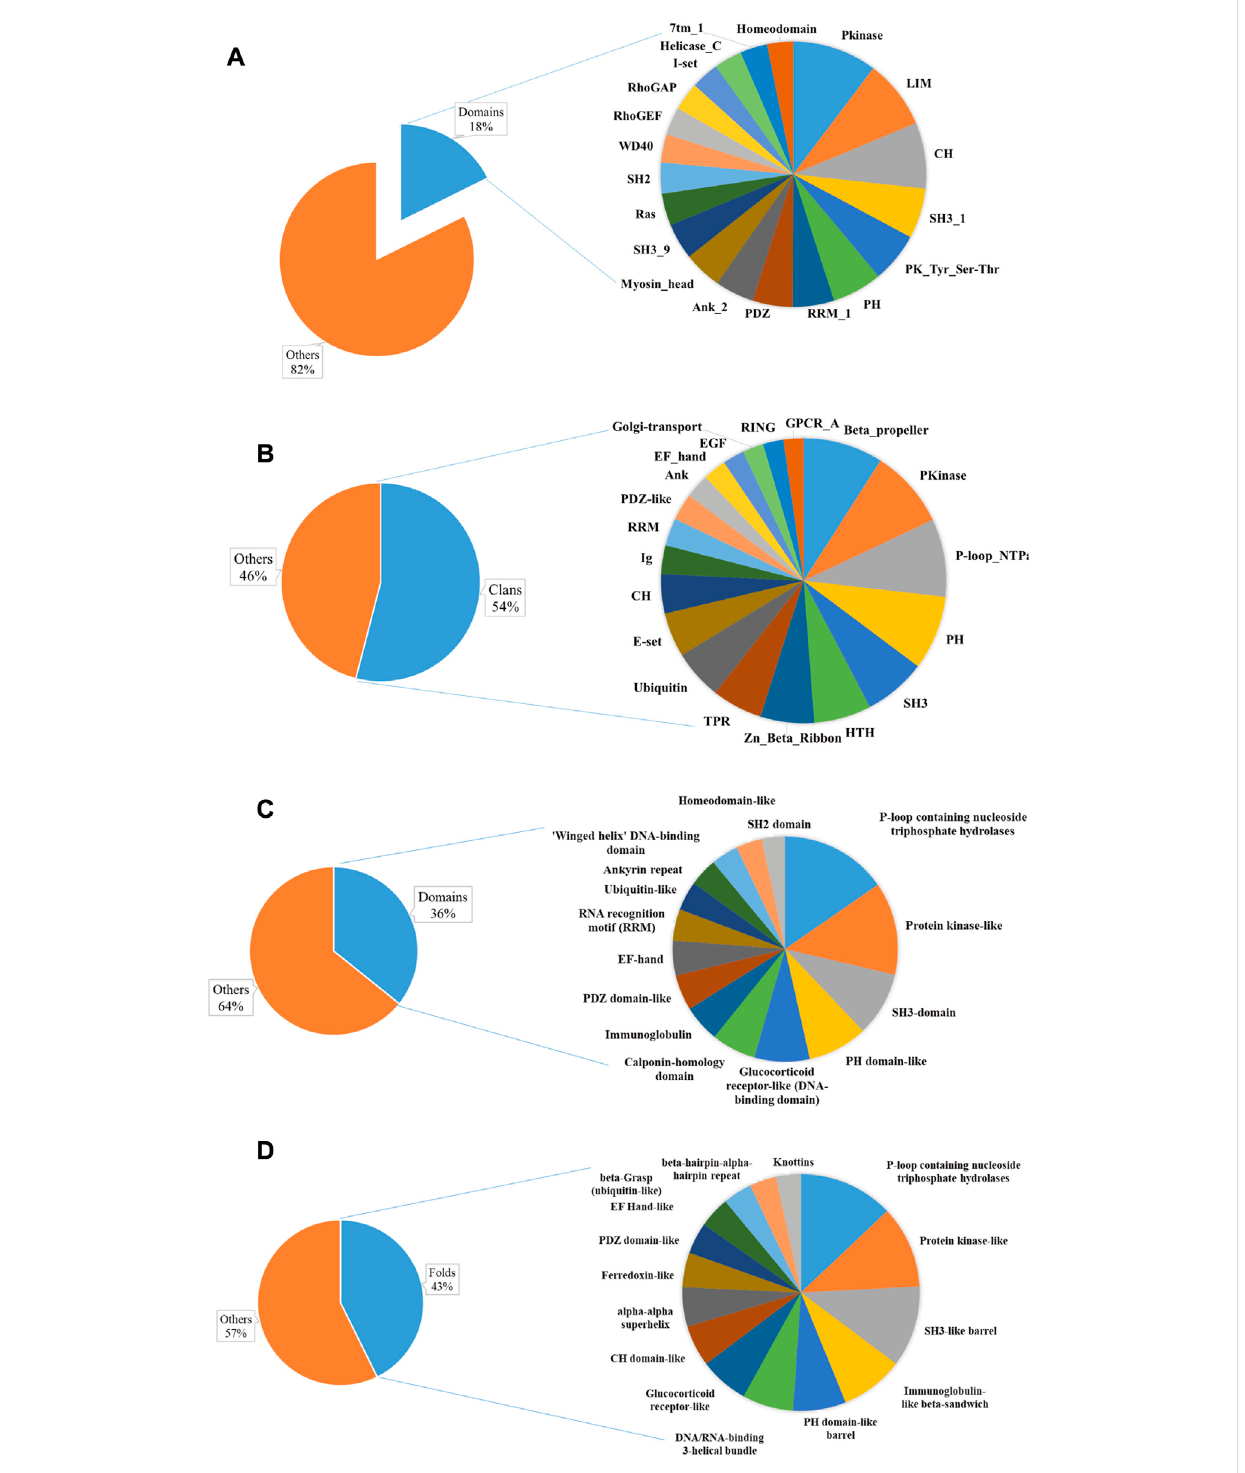
FIGURE 3 Sequence and structural domains in putative AAPs. The Pfam family (A) and clan (B) distributionhave been plotted as apie chart. The top 20 domain familiesrepresentonly18%ofthetotalPfamfamilies,indicatingdiversity.TheSCOPsuperfamily (C) ,fold (D) ,andclassdistributionhavebeenplotted.This shows the diversity of actin-binding domains in